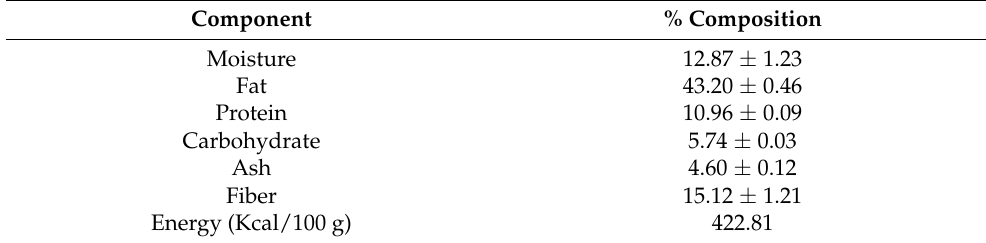
Table 1. Proximate composition of Balanites roxburghii seed kernel.